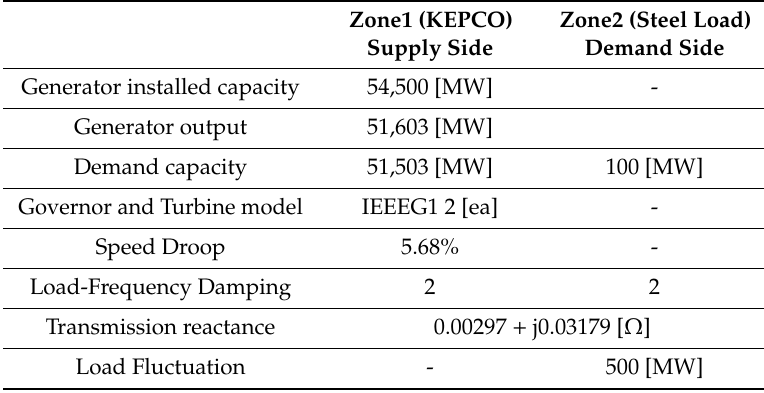
Table 6. The simulation data of grid-connected